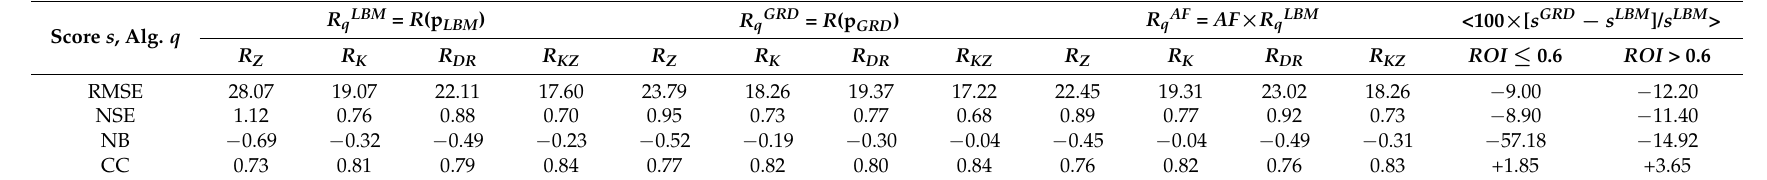
Table 4. As in Table 2 but for 14 October